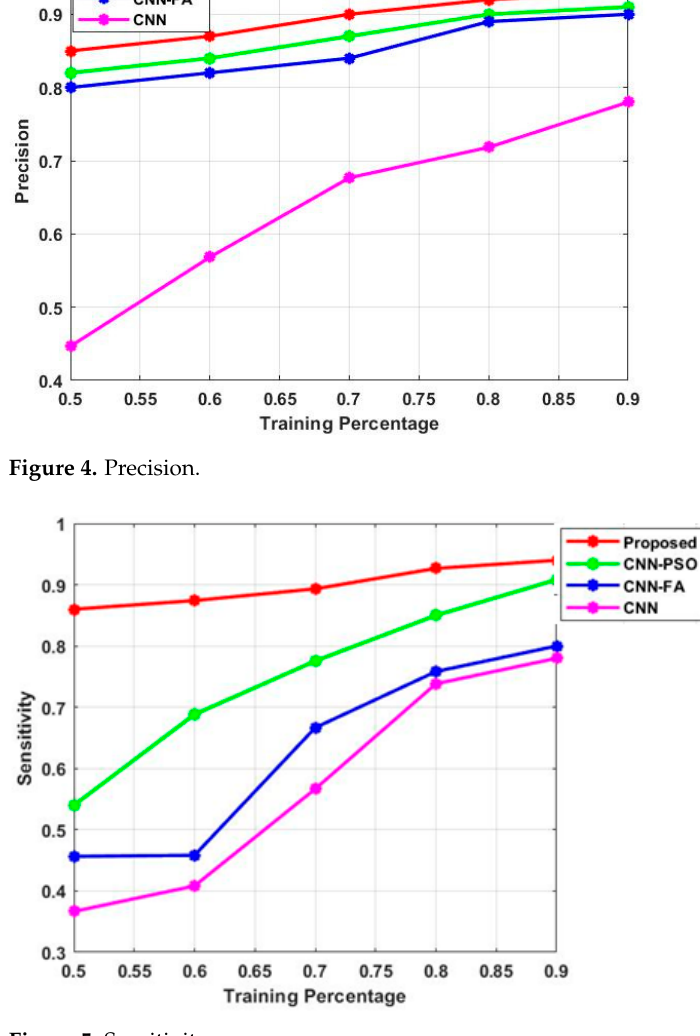
Figure 5. Figure 5. Sensitivity.